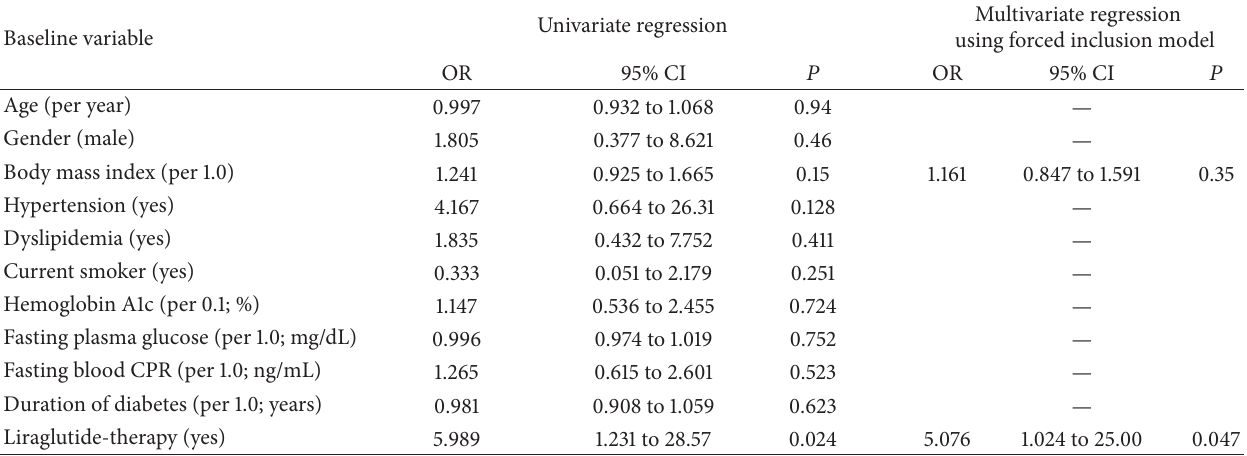
Table 3: Logistic regression analysis for the improvement of GIR ( > 0.5mg/min/kg) in patients with uncontrolled type 2 DM.